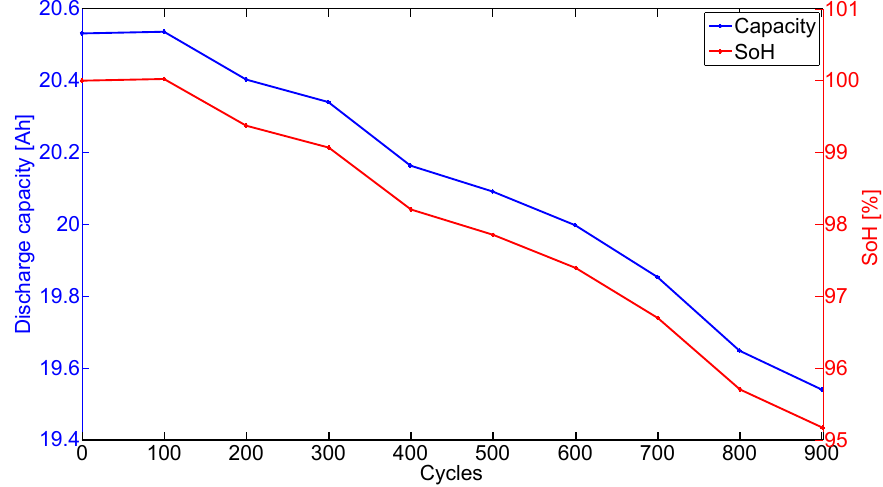
Figure 2. Aged battery cell discharge capacity and SoH evolutions with the number of